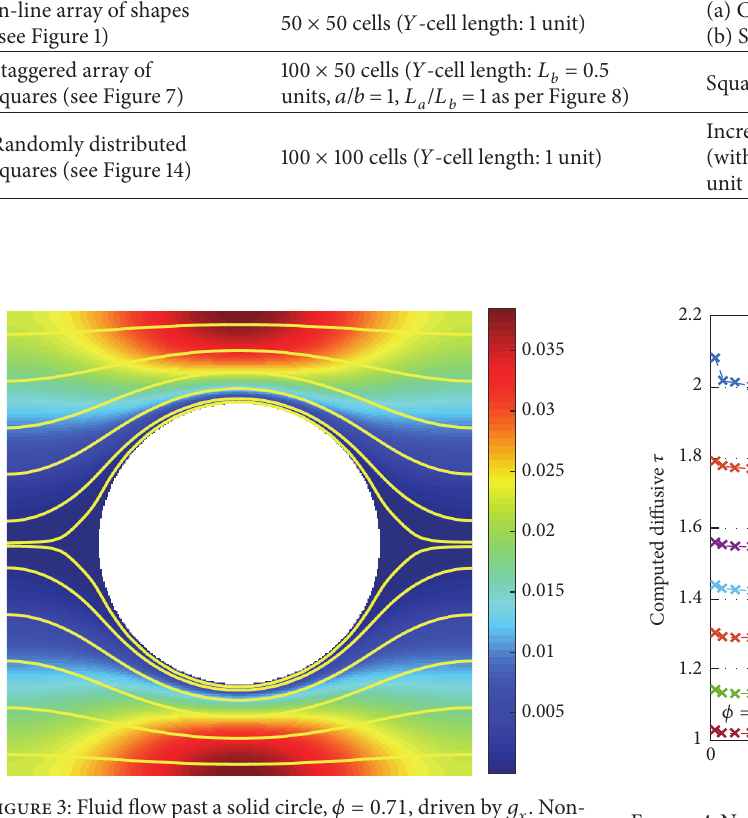
Figure4:Numberofgridcellsrequiredtoreachconverged 𝜏 𝑑 (using a convergence criteria of 0.1% relative error) for select porosities of in-line array of